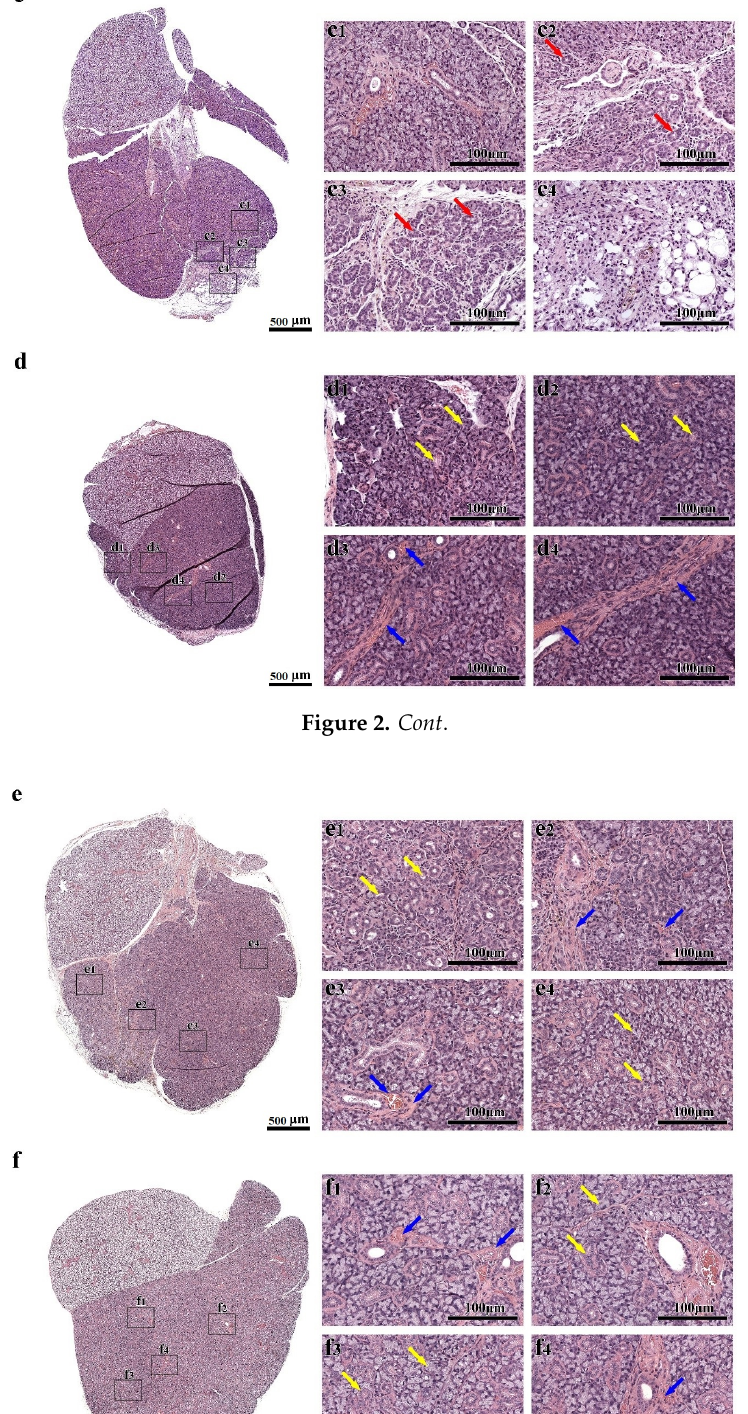
Figure 2. Cell sheets promote wound healing through twenty days post-transplantation. Shown are post-injured SMG (( a ) Day 8 or ( b ) Day 20), wounded SMG treated with cell sheets (( c ) Day 8 or ( d ) Day 20) and sham controls (( e ) Day 8 or ( f ) Day 20). Tissue sections were stained with hematoxylin–eosin and analyzed using a Leica DMI6000B microscope. Green arrows indicate vacuolated mononuclear cells, red arrows indicate acinar- and ductal-like structures, yellow arrows indicate parenchyma and blue arrows indicate stroma.